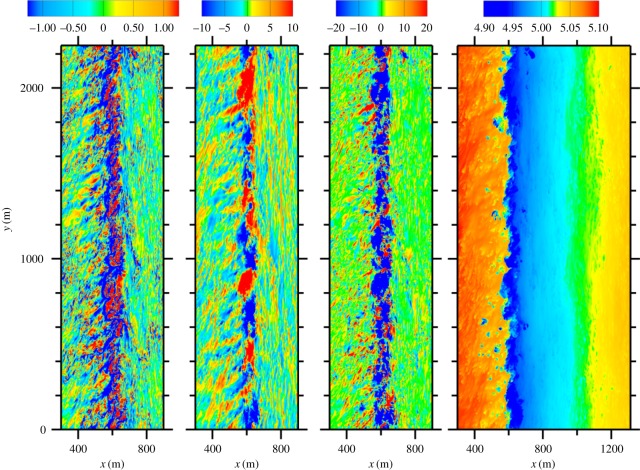
TTW-induced frontogenesis of a dense SBL filament at a time of incipient frontal arrest (i.e. t=4.2 h after the completion of the initialization phase) with a northward (down-front) wind stress in an LES simulation: (left to right) (x,y) snapshots of w/u*, v′/u*, u′v′/u∗2, and T [C] near the surface. The colour bars in the first three panels are saturated with some extrema outside the listed ranges [80].